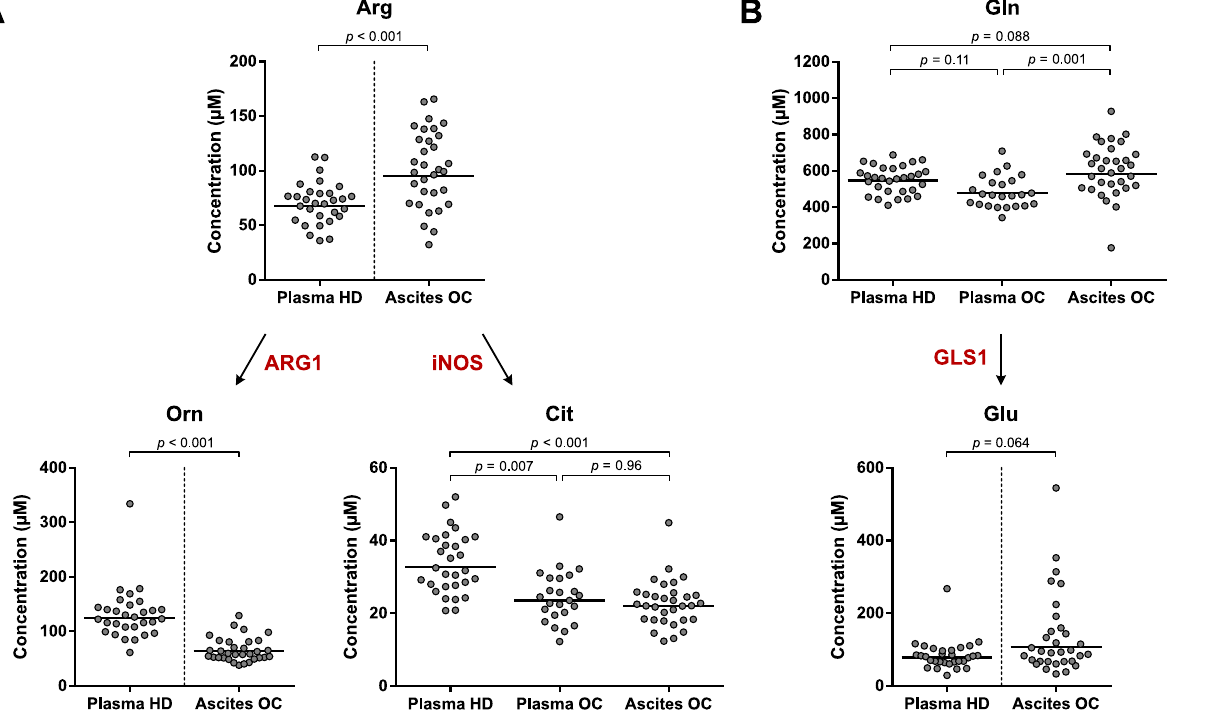
Figure 3. Arg and Gln metabolism in high-grade serous ovarian cancer patients and healthy donors. Amino acid and metabolite levels corresponding to ( A ) Arg and ( B ) Gln metabolism in plasma of healthy donors (HD) ( n = 30) and plasma and ascites of ovarian cancer patients (OC) ( n = 24 and 32, respectively, with n = 22 overlapping patients). The enzyme names indicate the enzymatic activities that are indirectly studied. Horizontal lines indicate geometric means. Repeated unpaired, two-tailed Kruskal–Wallis tests yielded significant results for comparison of Cit ( p < 0.001) and Gln levels ( p = 0.005) between the groups. Results of Dunn’s post hoc tests and unpaired, two-tailed Mann– Whitney U tests are indicated in the graphs. Arg: L -arginine; ARG1: arginase 1; Cit: L